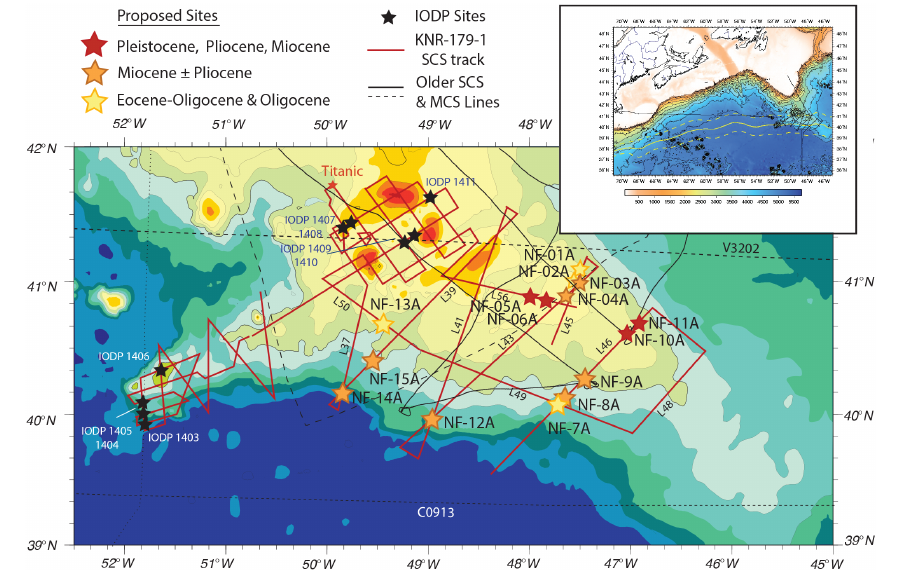
Figure 1. Track map for Newfoundland ridges showing existing SCS and MCS lines and proposed drill sites. Stars of different colors reflect the predominant age for the drilling targets at each site. Black stars are previous Eocene-focused sites drilled during IODP Expedition 342 (Norris et al., 2014).